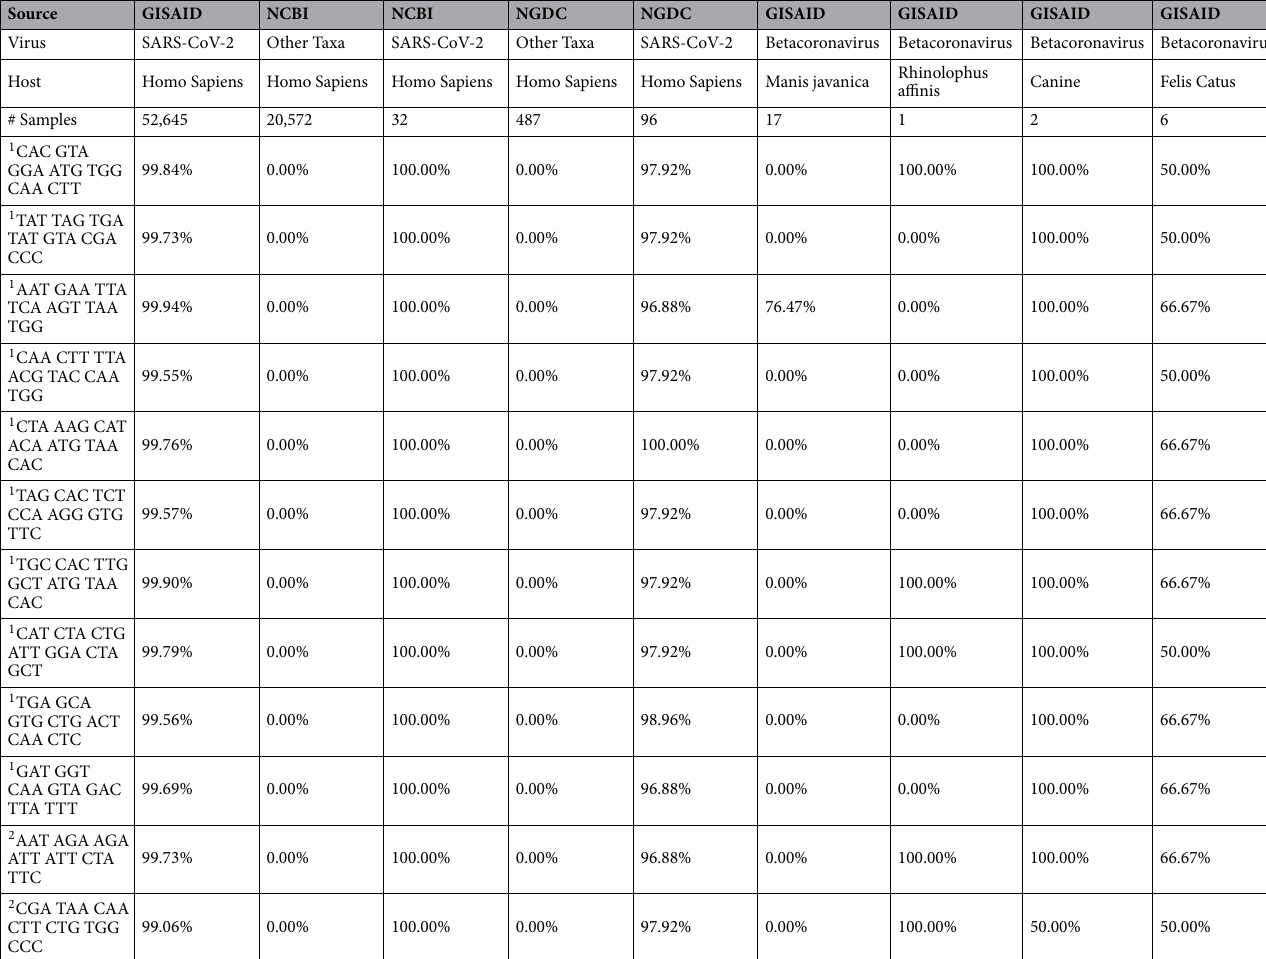
Table 1. Percentage of appearance for each of the 12 discovered 21-bps sequences across the different datasets, and comparison to similar viruses in nature and other hosts. 21-bps sequence resulting from experiment